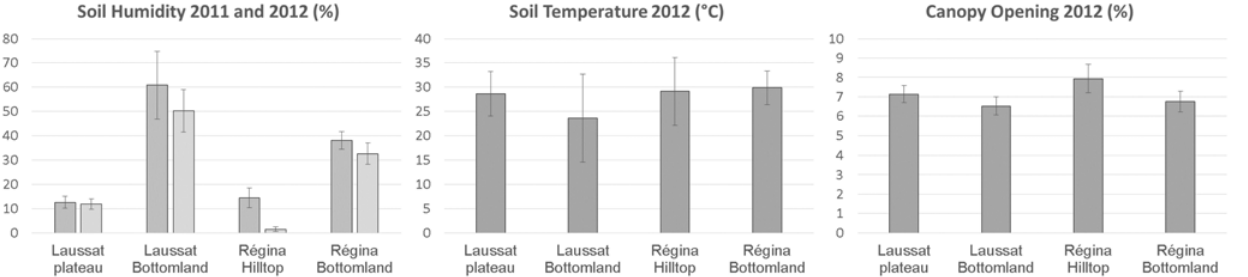
Fig 2. Environmental conditions in the study sites and local habitats: soil humidity (%), soil temperature (°C) and canopy opening (%). Complete data are provided in S1